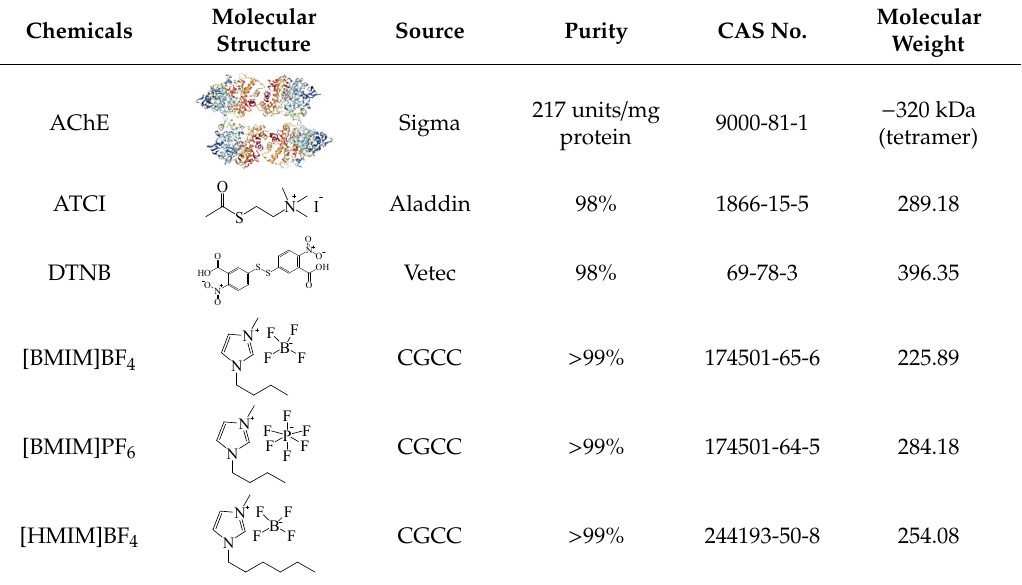
Table 3. Information about chemicals used in the experiment.